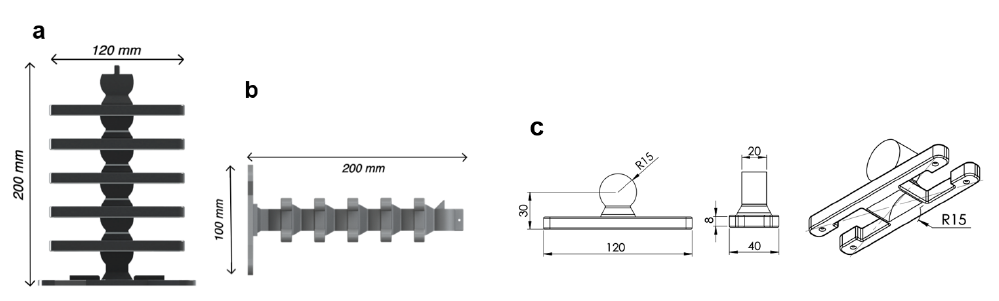
Figure 5. The musculoskeletal system consisted of six rigid segments: ( a ) front and ( b ) side views show the overall dimensions; and ( c ) shows the dimensions of a rigid segment, which consisted of four ribs. The fibers ran through holes in each segment to transmit the forces in hyperelastic material for actuation. The disk–socket joint enables rotation for undulation. The socket is the bottom cavity in the ( c ) isometric view.